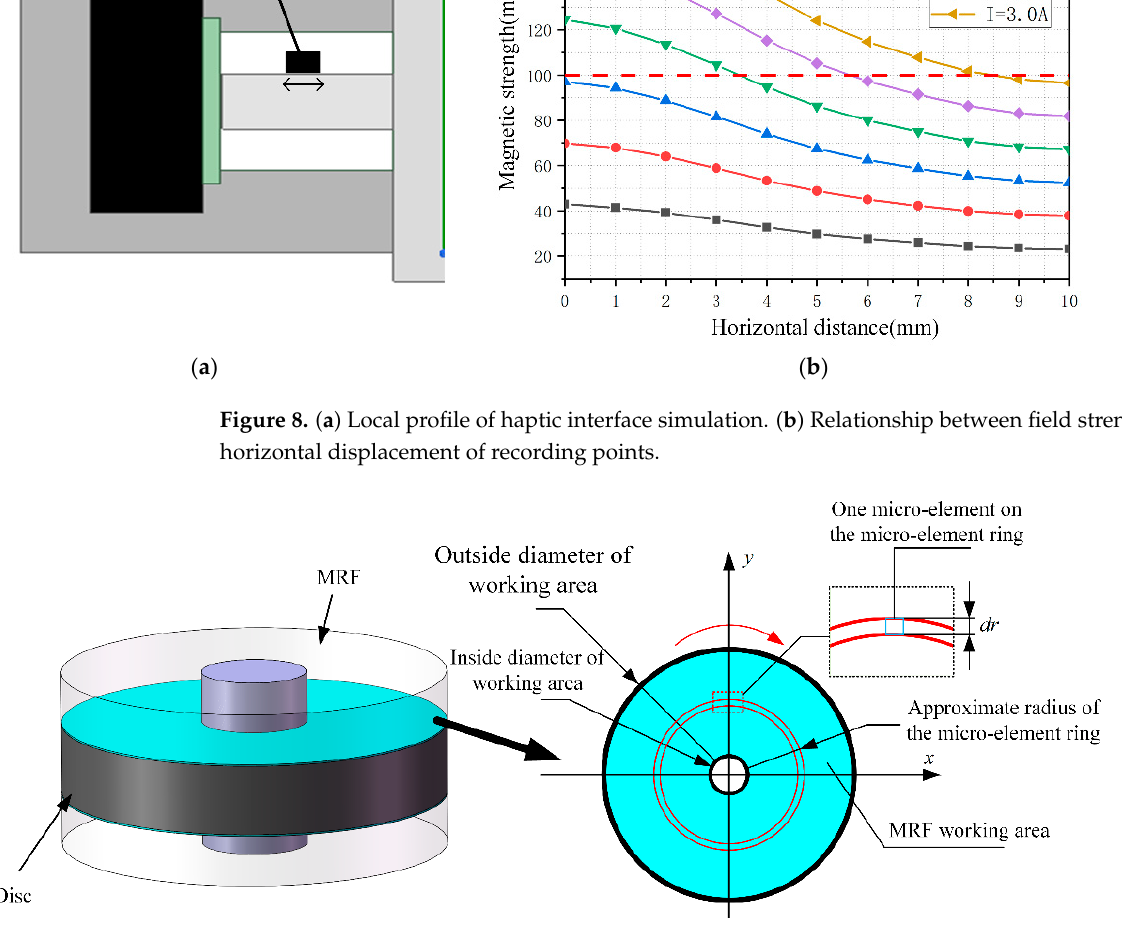
by this portion. Figure 9b shows the upper view of the fl uid particles in this part. After applying the magnetic fi eld, the working area formed by the force on the MRF particles is circular in shape. Figure 9. ( a ) Magnetorheological fl uid area. ( b ) Upper view of the MRF region generating resistance. Figure 9. ( a ) Magnetorheological fluid area. ( b ) Upper view of the MRF region generating